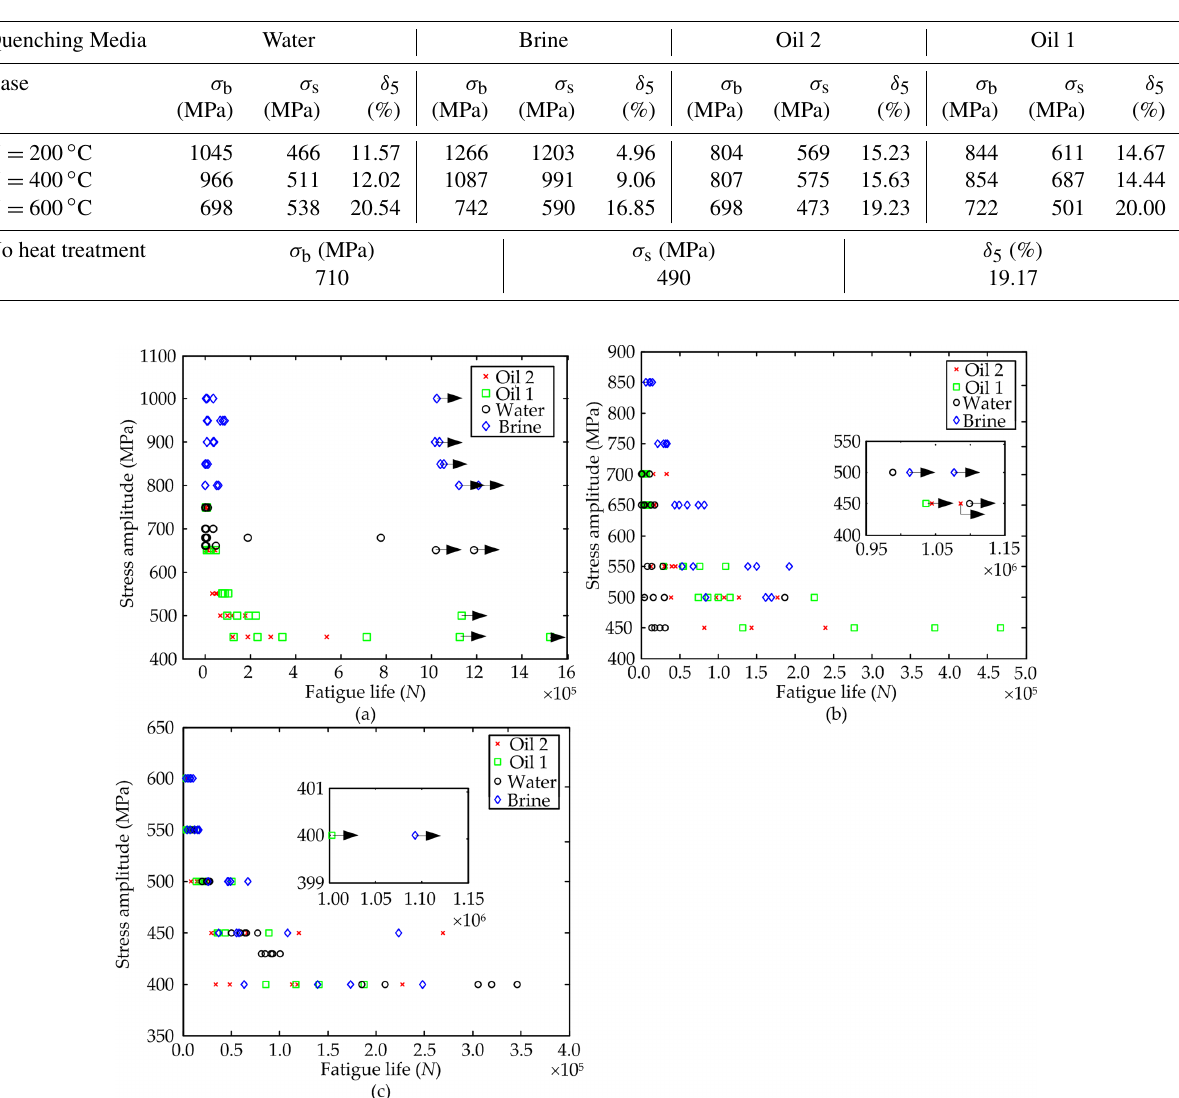
Table 2. Mechanical properties of 0.44% carbon steel.